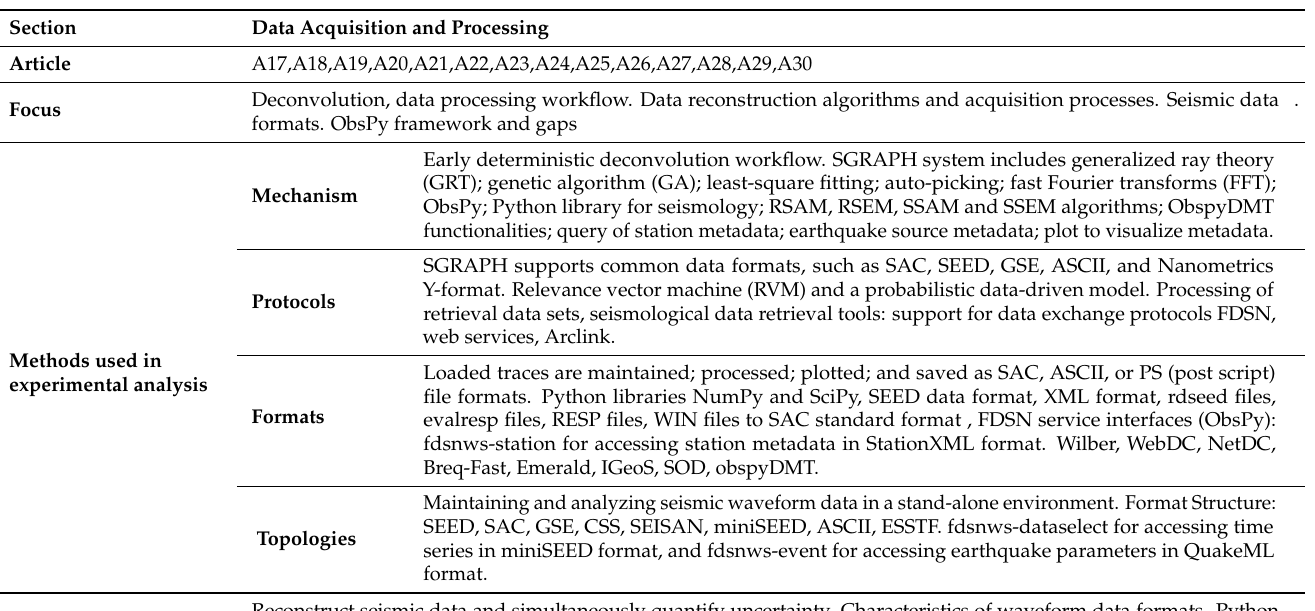
Table 5. Data Acquisition and